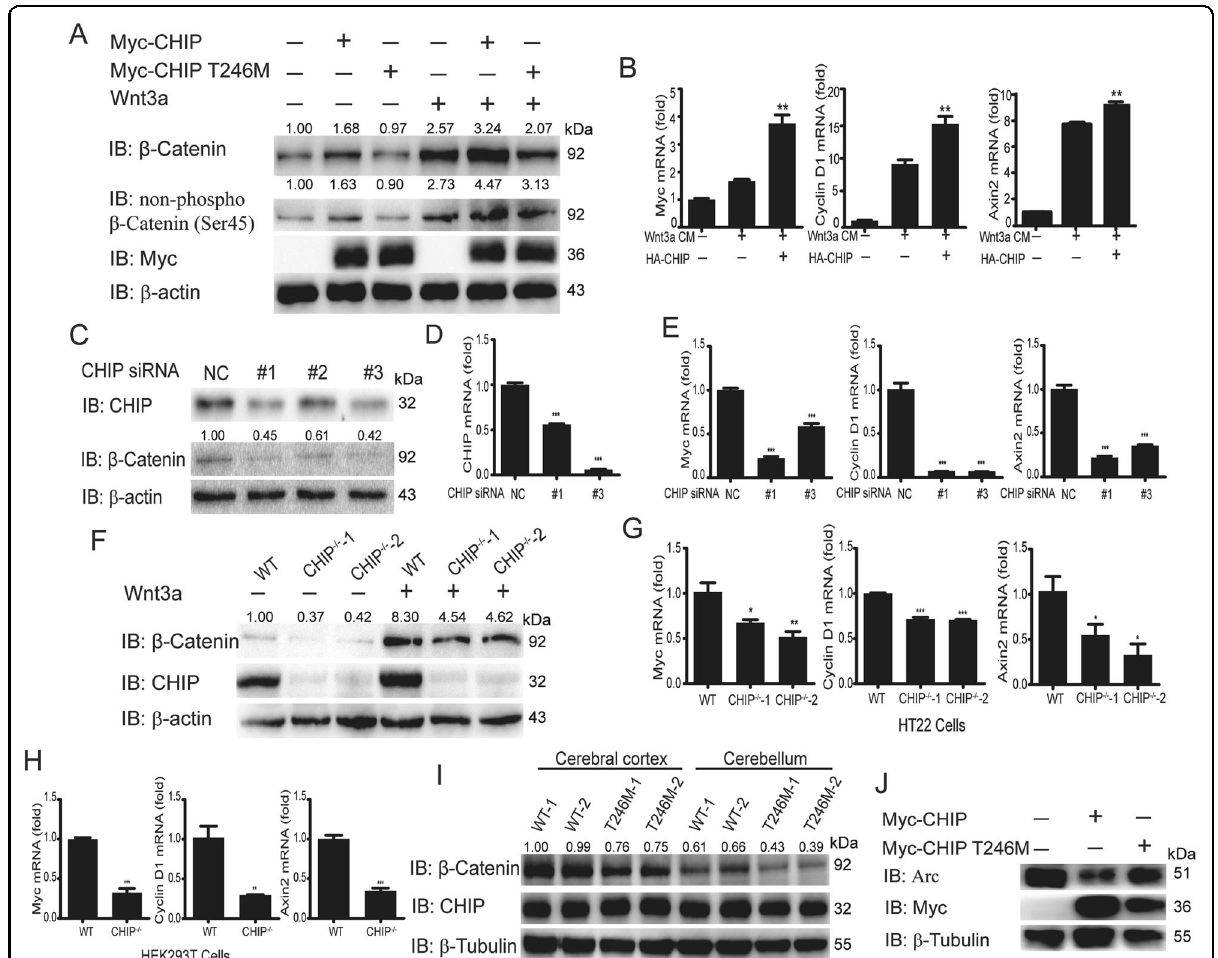
Fig. 1 CHIP promotes the activation of Wnt signaling and the degradation of Arc. A CHIP increased the protein levels of β -catenin and non- phospho- β -catenin detecting by immunoblotting. HEK293T cells were transfected with an empty vector, Myc-CHIP, or Myc-CHIP T246M, and stimulated with Wnt3a (40 ng/ml) for 2 h. B HEK293T cells were transfected with an empty vector or HA-CHIP, and stimulated with Wnt3a CM or Ctrl- CM for 12 h. Wnt target genes ( Myc , Cyclin D1 , and Axin2 ) expression were analyzed by quantitative real-time PCR. C – D The knockdown ef fi ciency of CHIP-speci fi c siRNAs in protein level ( C ) and mRNA level ( D ). C , E Knockdown of CHIP reduced endogenous β -catenin detecting by immunoblotting ( C ), and inhibited Wnt target genes ( Myc , Cyclin D1 , and Axin2 ) expression detecting by quantitative real-time PCR ( E ) in SHSY5Y cells after CHIP- speci fi c siRNAs transfection. F Western blot analysis of endogenous β -catenin in WT and CHIP − / − HT22 cells with Wnt3a stimulation or not. G – H Myc , Cyclin D1 , and Axin2 mRNA abundance were analyzed by quantitative real-time PCR in WT and CHIP − / − HT22 cells ( G ), as well as WT and CHIP − / − 293T cells ( H ). I Immunoblot analysis of the protein level of β -catenin in cerebral cortex and cerebellum from the rat models of SCAR16 induced by CHIP T246M mutant or WT rats. J Immunoblotting analysis of the protein level of Arc after transfected with Myc-CHIP WT or Myc-CHIP T246M in SHSY5Y cells. All results were representative of three independent experiments. The graphs showed the means ± SD of three independent experiments. * P < 0.05, ** P < 0.01, and *** P < 0.001 (Student ’ s t